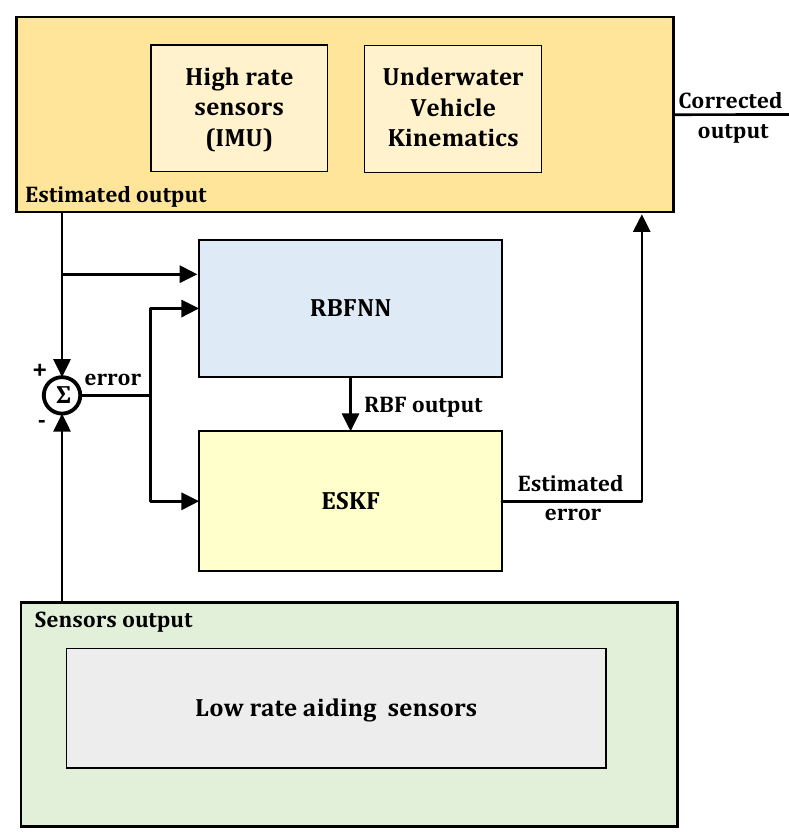
Figure 3. Complementary form representation of RBF-ESKF. Algorithm 1 shows iterative steps of the proposed method. The term ˜ s k is RBF modified innovation term used by RBF-ESKF to improve accuracy of filter in highly non- linear